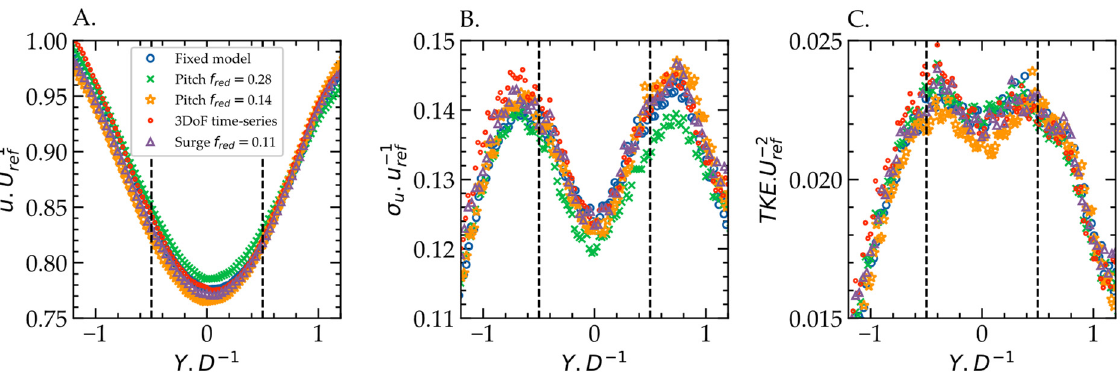
Figure 4. Statistics of the far-wake velocity field at hub height (Z = 0) versus the lateral distance; ( A ) Streamwise velocity; ( B ) Standard deviation of streamwise velocity; ( C ) Turbulence kinetic energy (TKE).